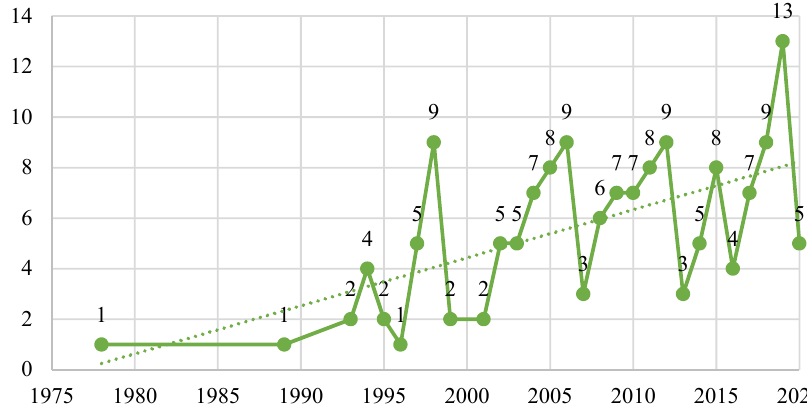
Figure 7. Search query: clozapine and pregnancy.